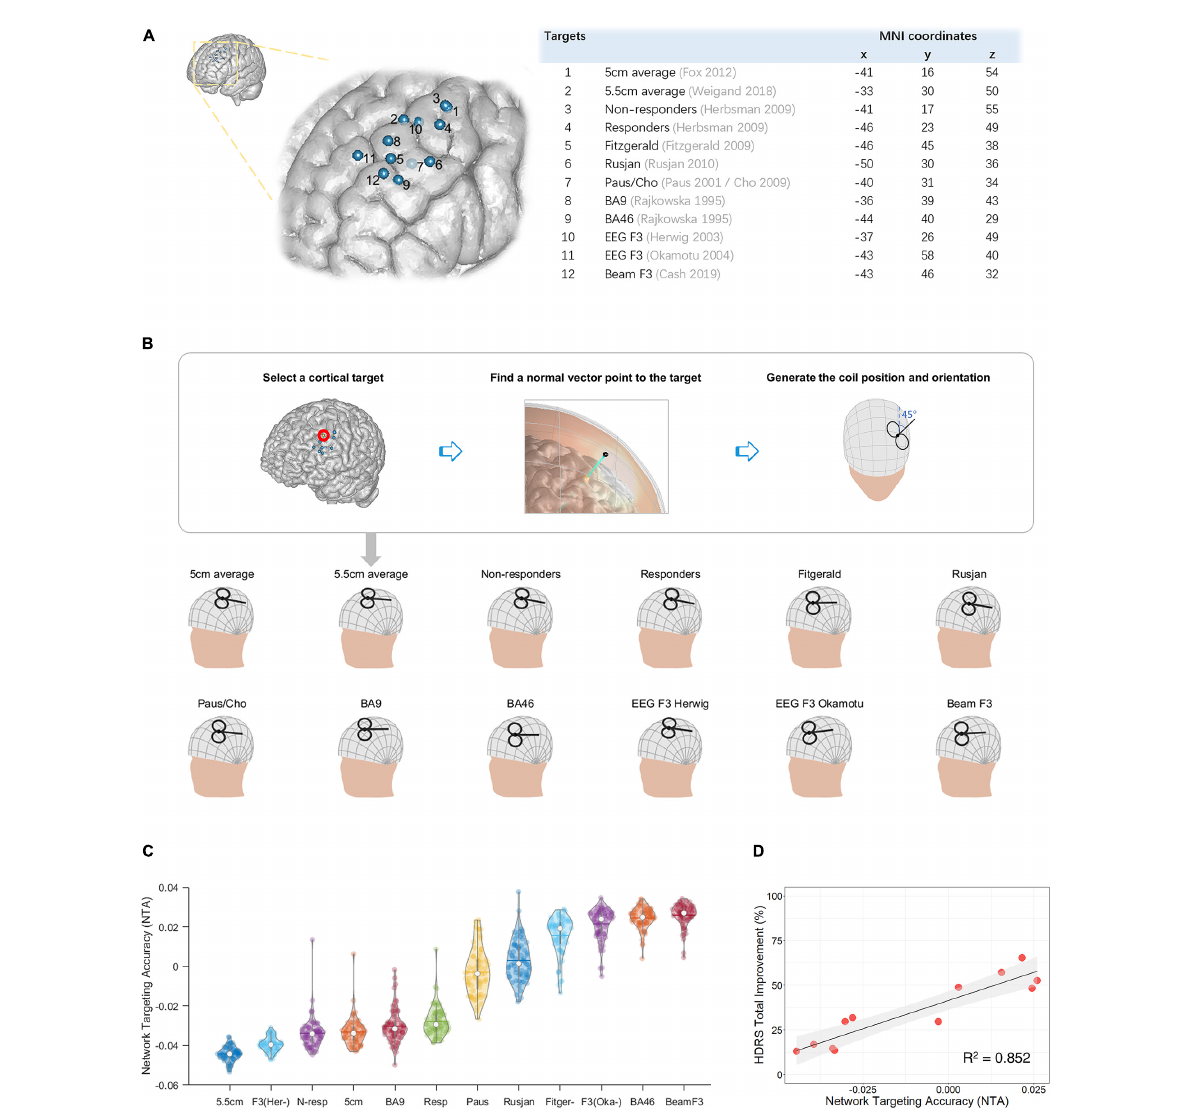
FIGURE2 Network targeting model predicts the equation-based transcranial magnetic stimulation (TMS) treatment efficacy at empirical dorsolateral prefrontal cortex (DLPFC) sites in a large depression cohort. (A) Empirical target sites of major depressive disorder (MDD) are shown in MNI-152 (Fonov et al., 2011). (B) Restoration of TMS parameters from targeted cortical sites. (C) Network targeting accuracy (NTA) of empirical sites across different individuals, each represented with a colored dot ( N = 68). (D) Correlation between the average NTA and the equation-based HDRS total improvement ( p = 9.32 × 10 − 6 ,